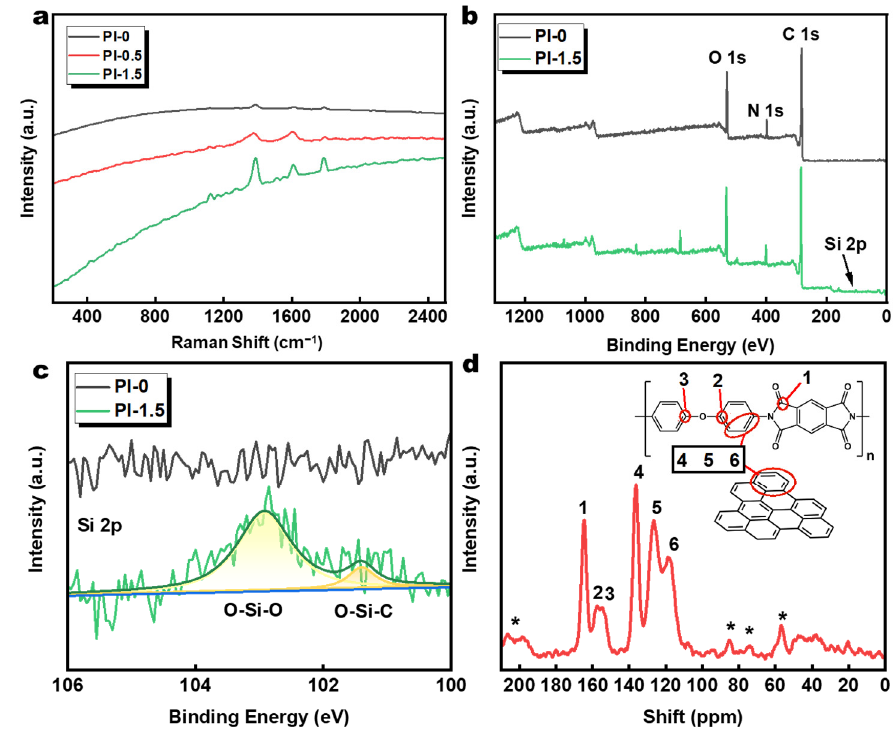
Figure 4. ( a ) Raman spectra of PI-0, PI-0.5, and PI-1.5. ( b ) XPS and ( c ) Si 2p spectra of PI-0 and PI-1.5. ( d ) Solid-state 13 C NMR spectra of the PI-1.5; * indicates peaks from spinning sidebands.